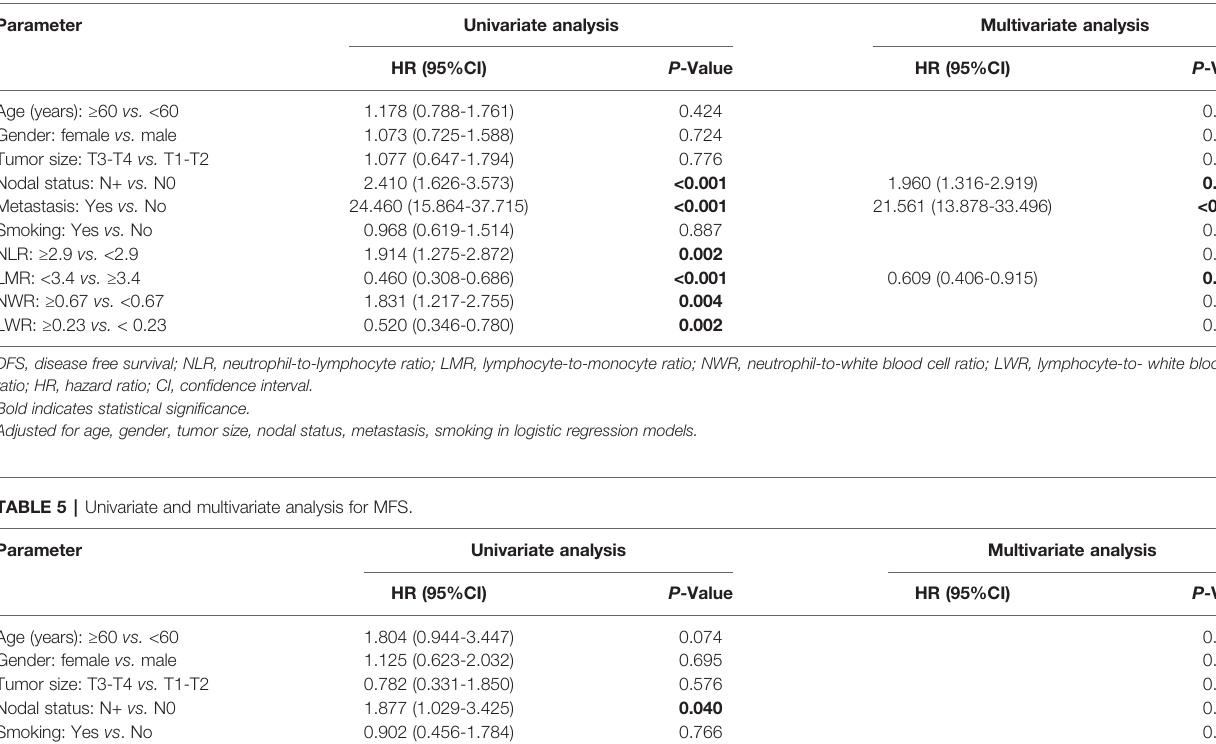
TABLE 4 | Univariate and multivariate analysis for DFS.